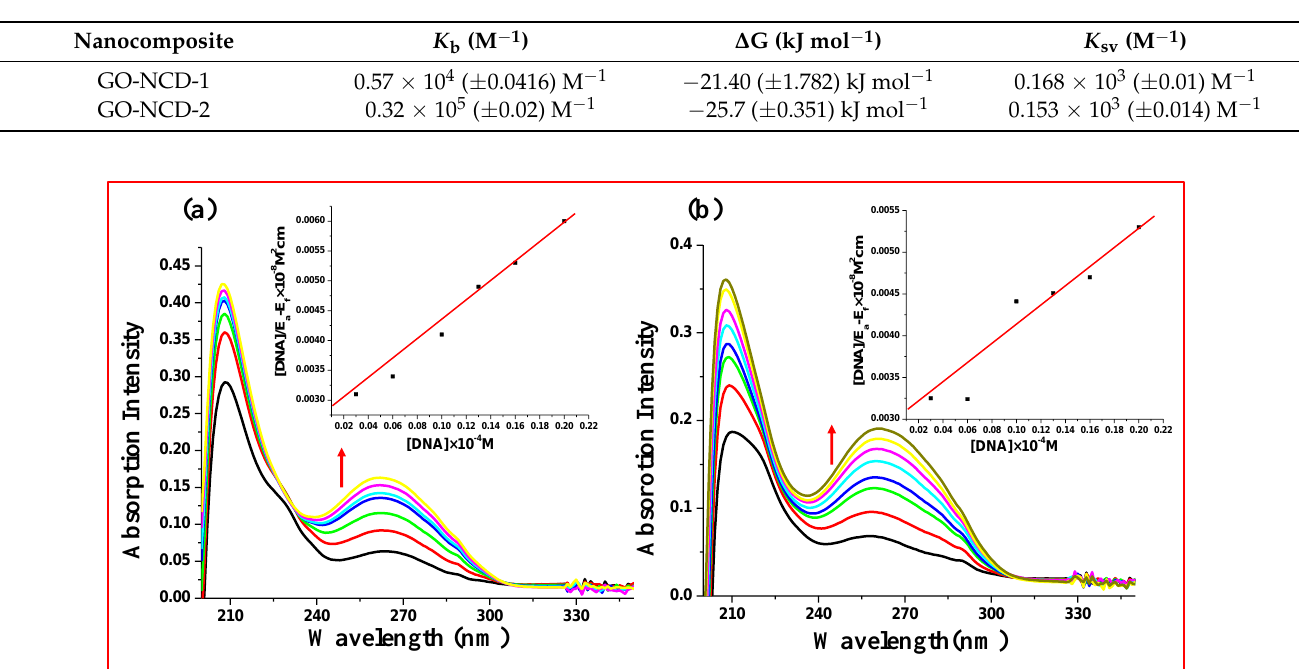
Table 1. Calculated K b and K sv values of GO-NCD- 1 and GO-NCD- 2 .